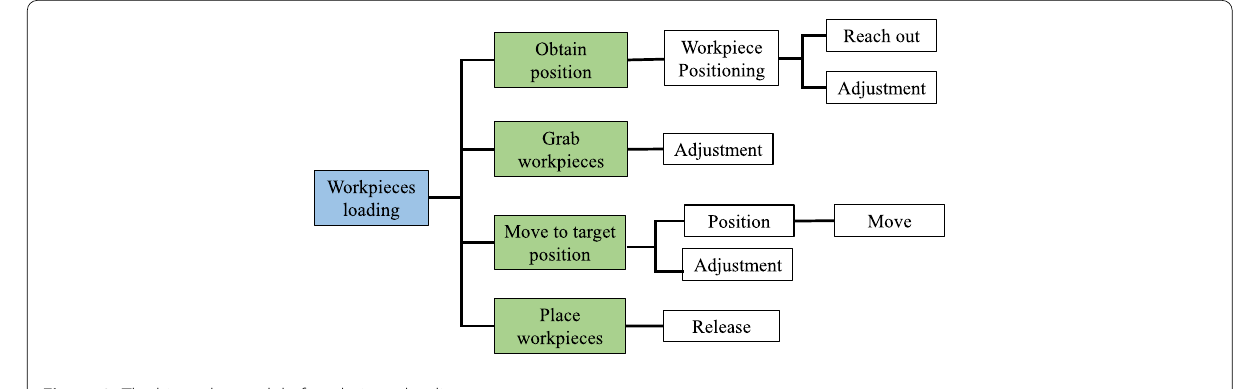
Figure 3 The hierarchy model of workpieces loading